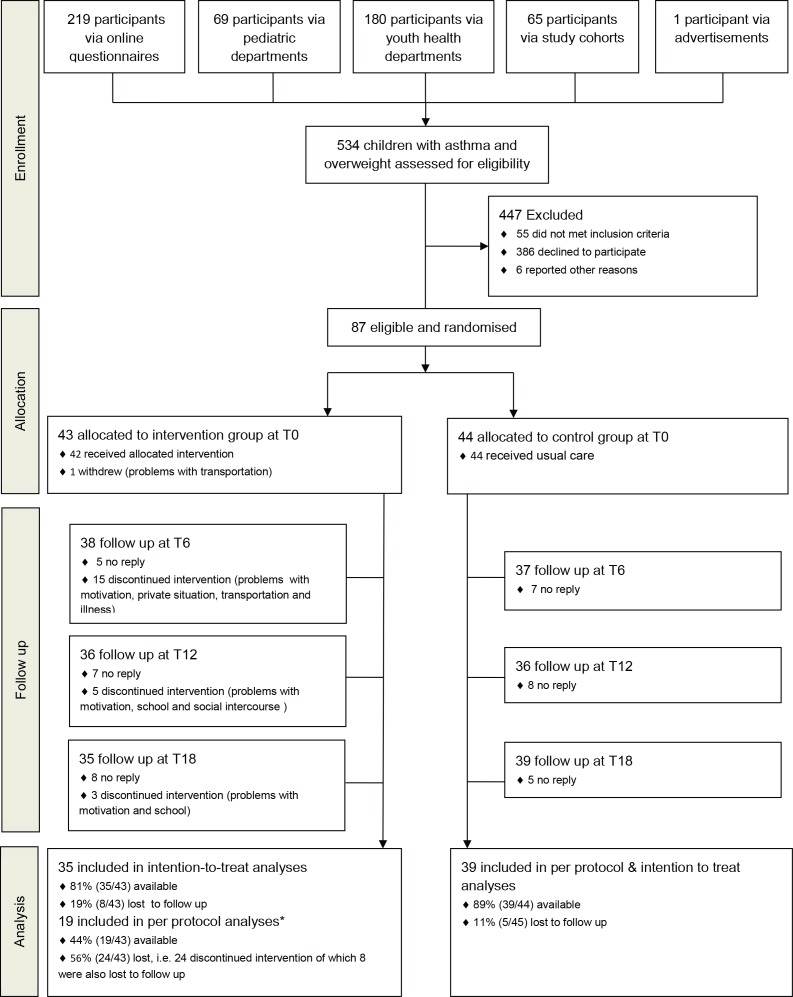
Consort flow diagram.* Two participants discontinued the sport sessions during the follow-up phase of the intervention due to membership of an organised sports association, but did continue to attend the lifestyle, individual and parental sessions. Those participants were included in the per protocol analysis.